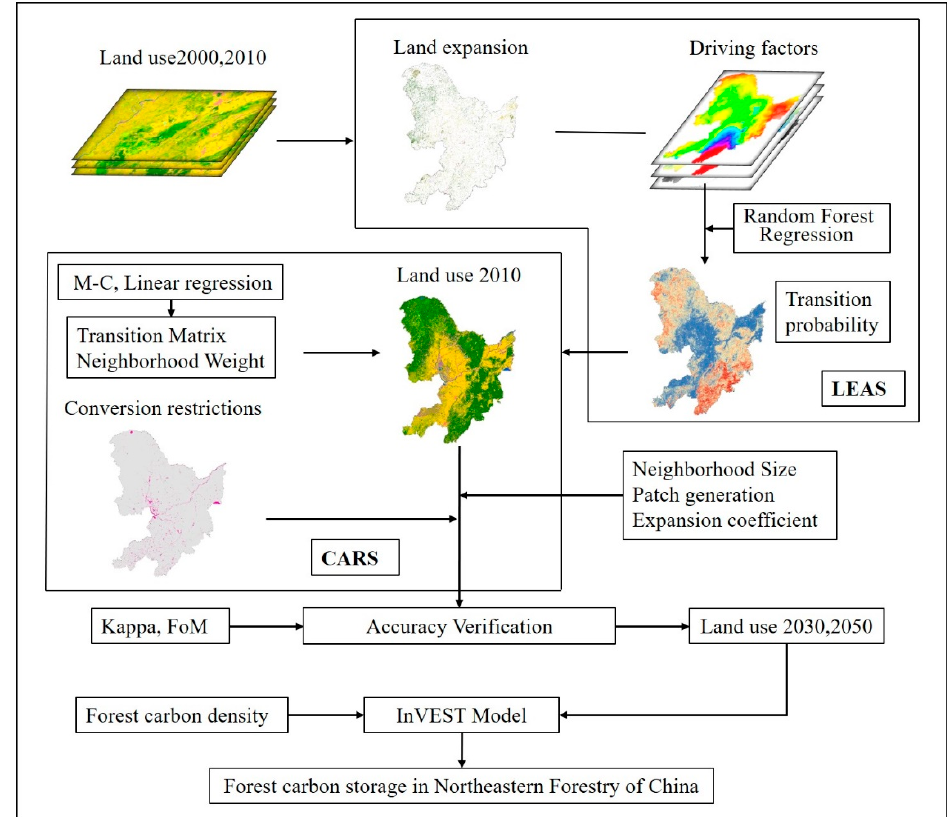
Figure 3. Calculation process of carbon storage in Northeast Forestry of China.2.2.3 InVEST model and forest carbon density